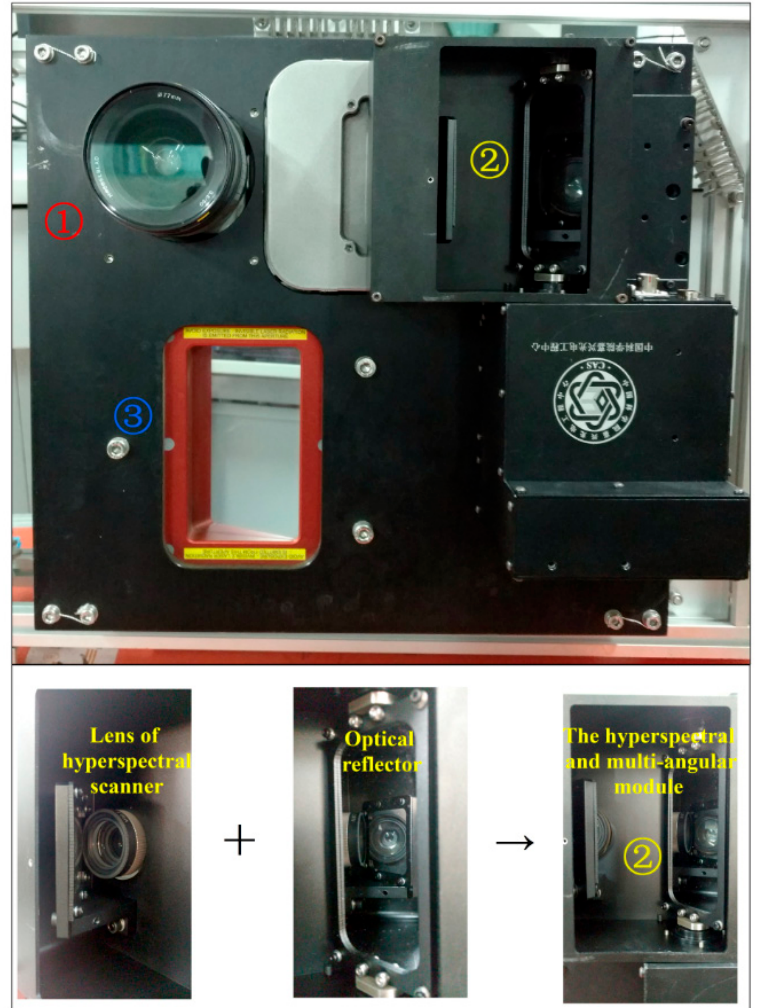
Figure 2. Layout of lenses of different sensors. ① lens of CCD camera and ② l ens of hyperspectral sensor and multi-angular module. ③ reflecting mirror of laser scanner.